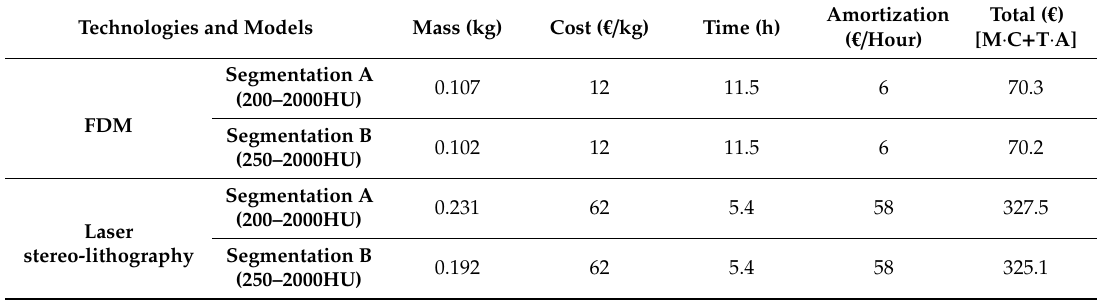
Table 4. Cost evaluation regarding the di ff erent alternatives: Based on the actual quantities and cost of materials used, on the di ff erent manufacturing times and on real machine